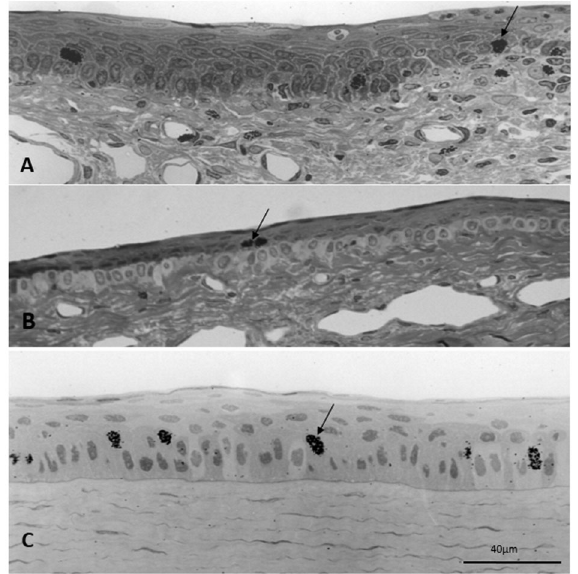
Figure 2. Autoradiography of semithin sections of control eyes injected with [ 3 H]-TdR. Six hours after the intravitreal injection showing the limbus in a region in-between extraocular muscle insertions ( A ) and at the insertion of the superior rectus muscle ( B ). The central cornea is shown in Panel C . Labeled nuclei (arrows) were observed in the basal stratum and the immediate superior layer, either in the limbus and central